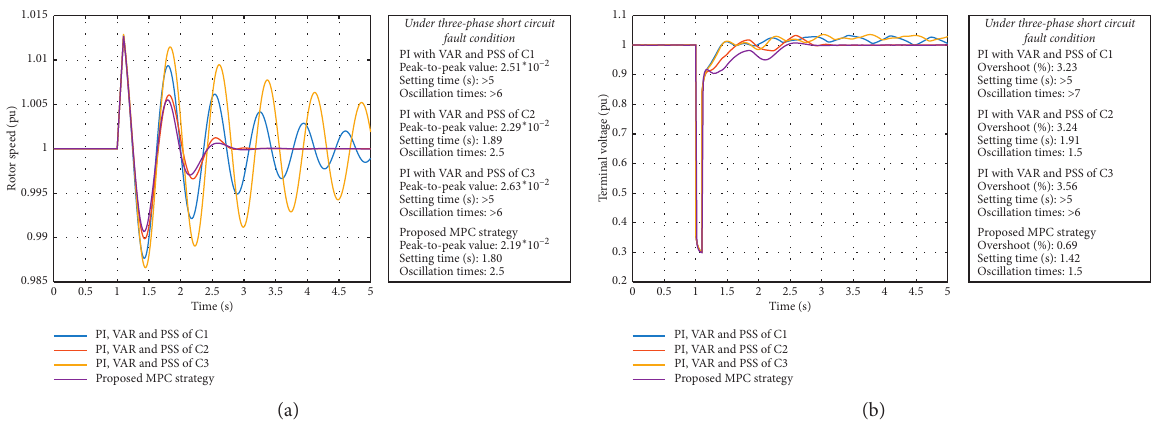
Figure 16: Response comparison under a three-phase short circuit fault condition. (a) Rotor speed response. (b) Terminal voltage response.